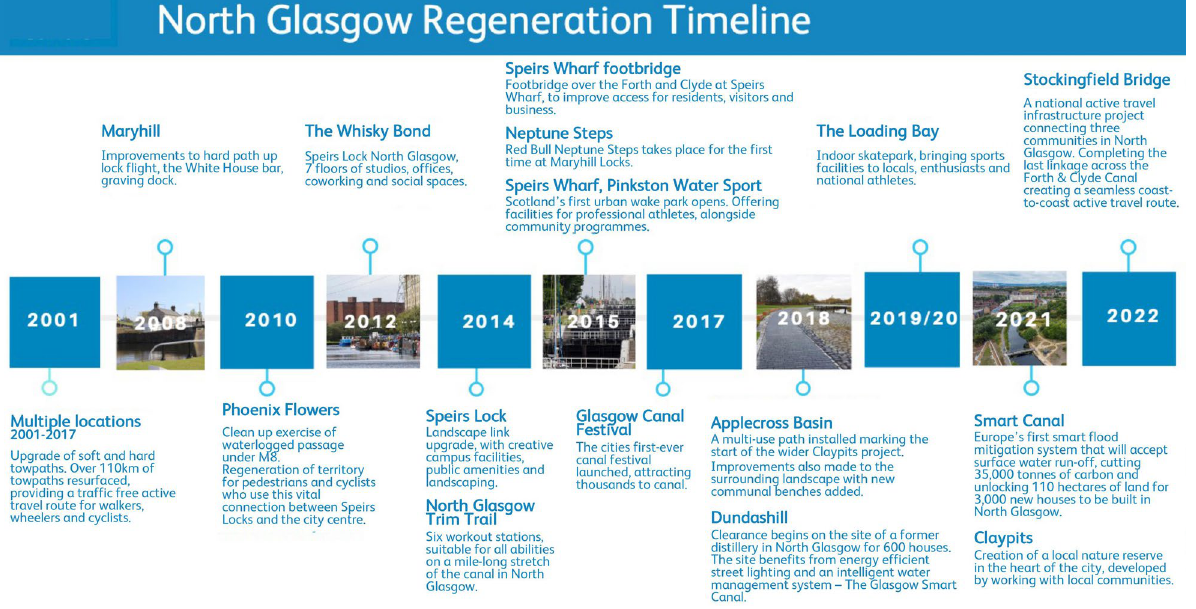
Figure 1. Schematic diagram showing the timeline of the canal regeneration programme in the North of Glasgow City from complete closure and dereliction to re-opening in North Glasgow in Scotland 10